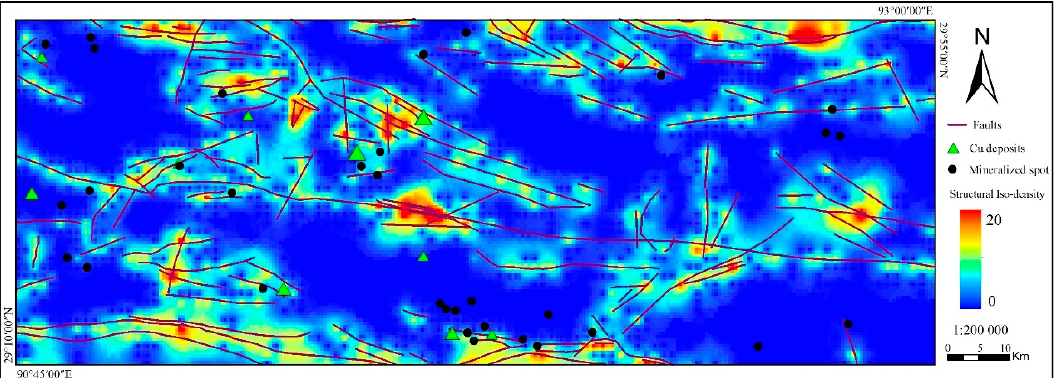
Figure 4. The structural iso-density map.